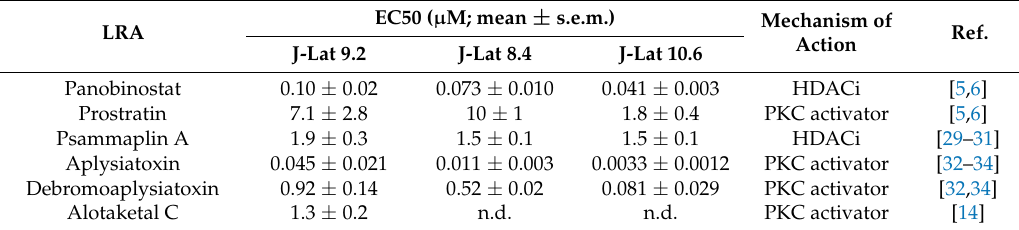
Table 1. 50% effective concentrations (EC 50 s) of latency-reversing agents (LRAs). EC 50 s were calculated in J-Lat 9.2, 8.4, and 10.6 cells based on the percent of GFP expression relative to controls treated with 12, 38, or 3.8 µ M prostratin, respectively, using the approach of Hashemi et al. [28]. n.d., not determined. EC50 ( µ M; mean ± LRA